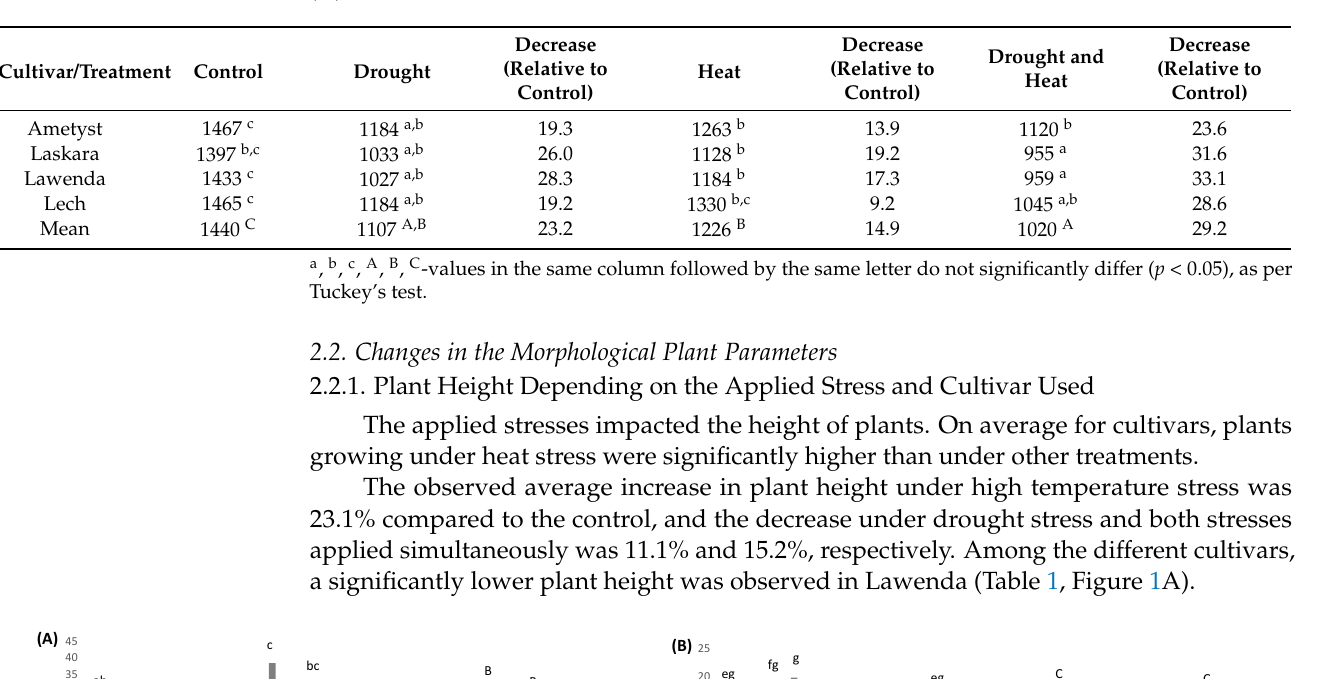
Table 2. Tuber yield (g/plant) depending on the applied stress, potato cultivar and the yield decrease (%) in relation to the control.